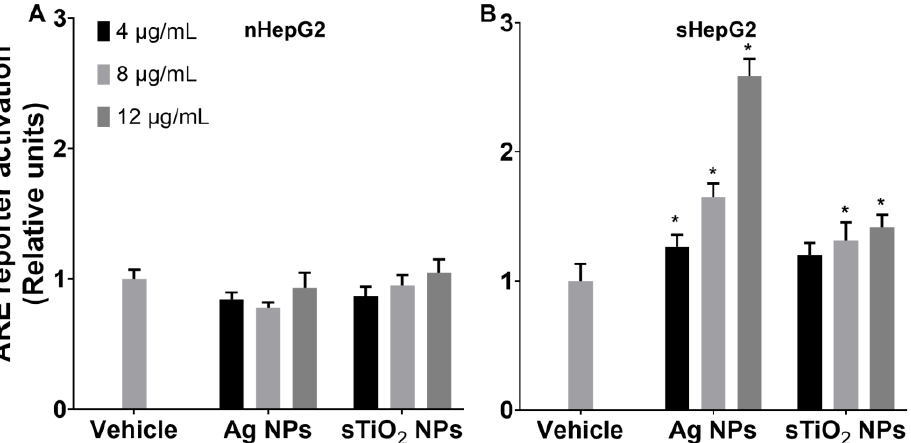
Figure 4. Upregulation of ARE reporter gene only in sHepG2 cells in response to NP exposure. ( A , B ) ARE reporter activation in nHepG2 ( A ) and sHepG2 cells ( B ) treated with Ag NPs or sTiO 2 NPs. Data are shown as means ± s.d., n = 5. * p < 0.05, compared with vehicle